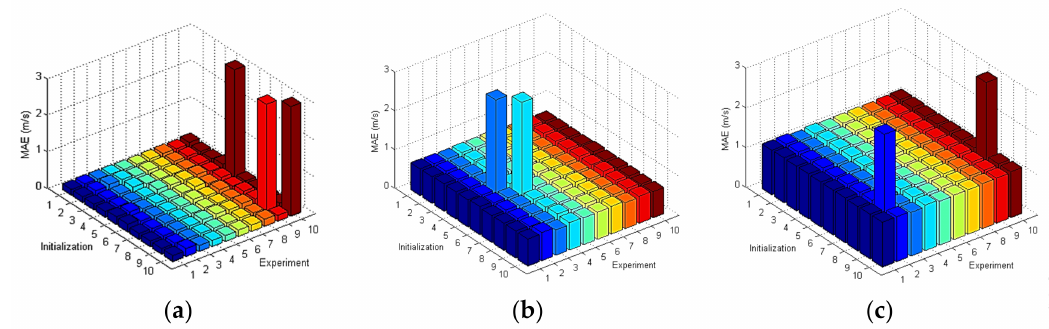
Figure 13. MAE values for the test set of Macau—( a ) 1 h; ( b ) 6 h; and ( c ) 24 h ahead. Experiments are described in Section 2.6.5.